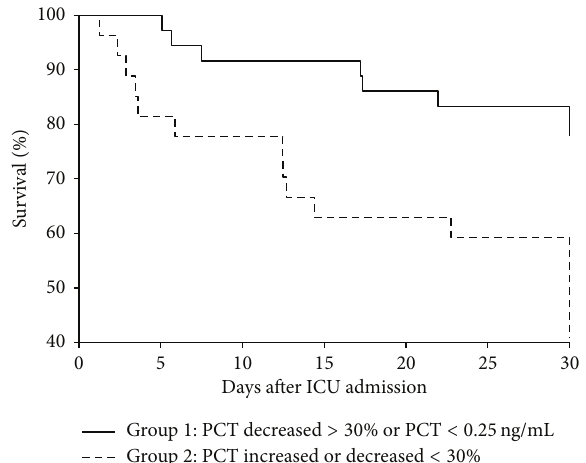
Figure 3: Kaplan Meier 30-day survival curve for groups 1 and 2. Log Mantel Cox Test ( 𝑃 = 0.002)